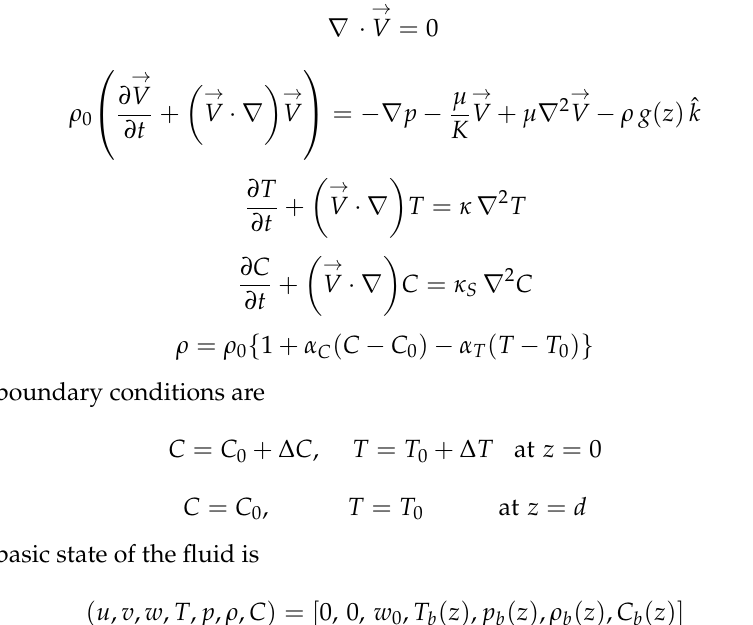
Figure 1. Physical model.